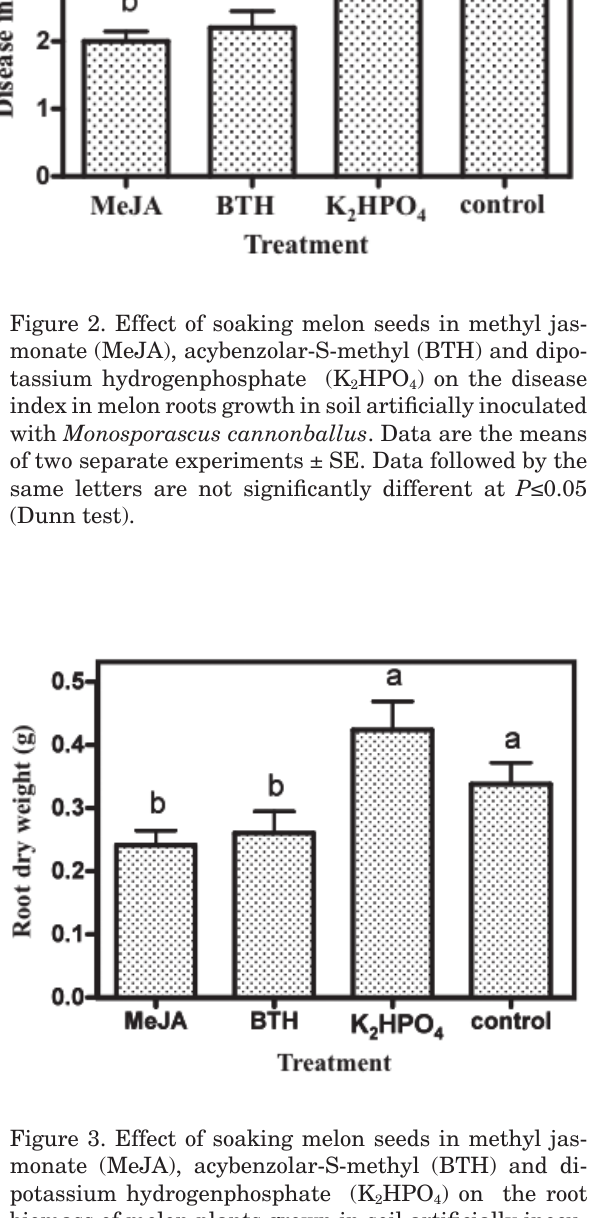
HPO ) on the root 2 4